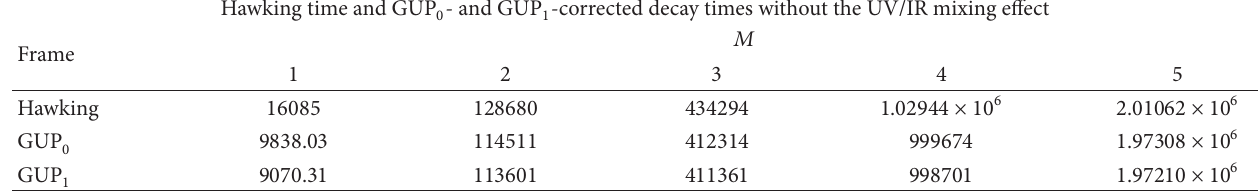
Table 1: Hawking time and GUP 0 - and GUP 1 -corrected decay times with the black hole mass 𝑀 = 1, 2, .. ., 5 (in Planck units) and 𝛼 = 1 .